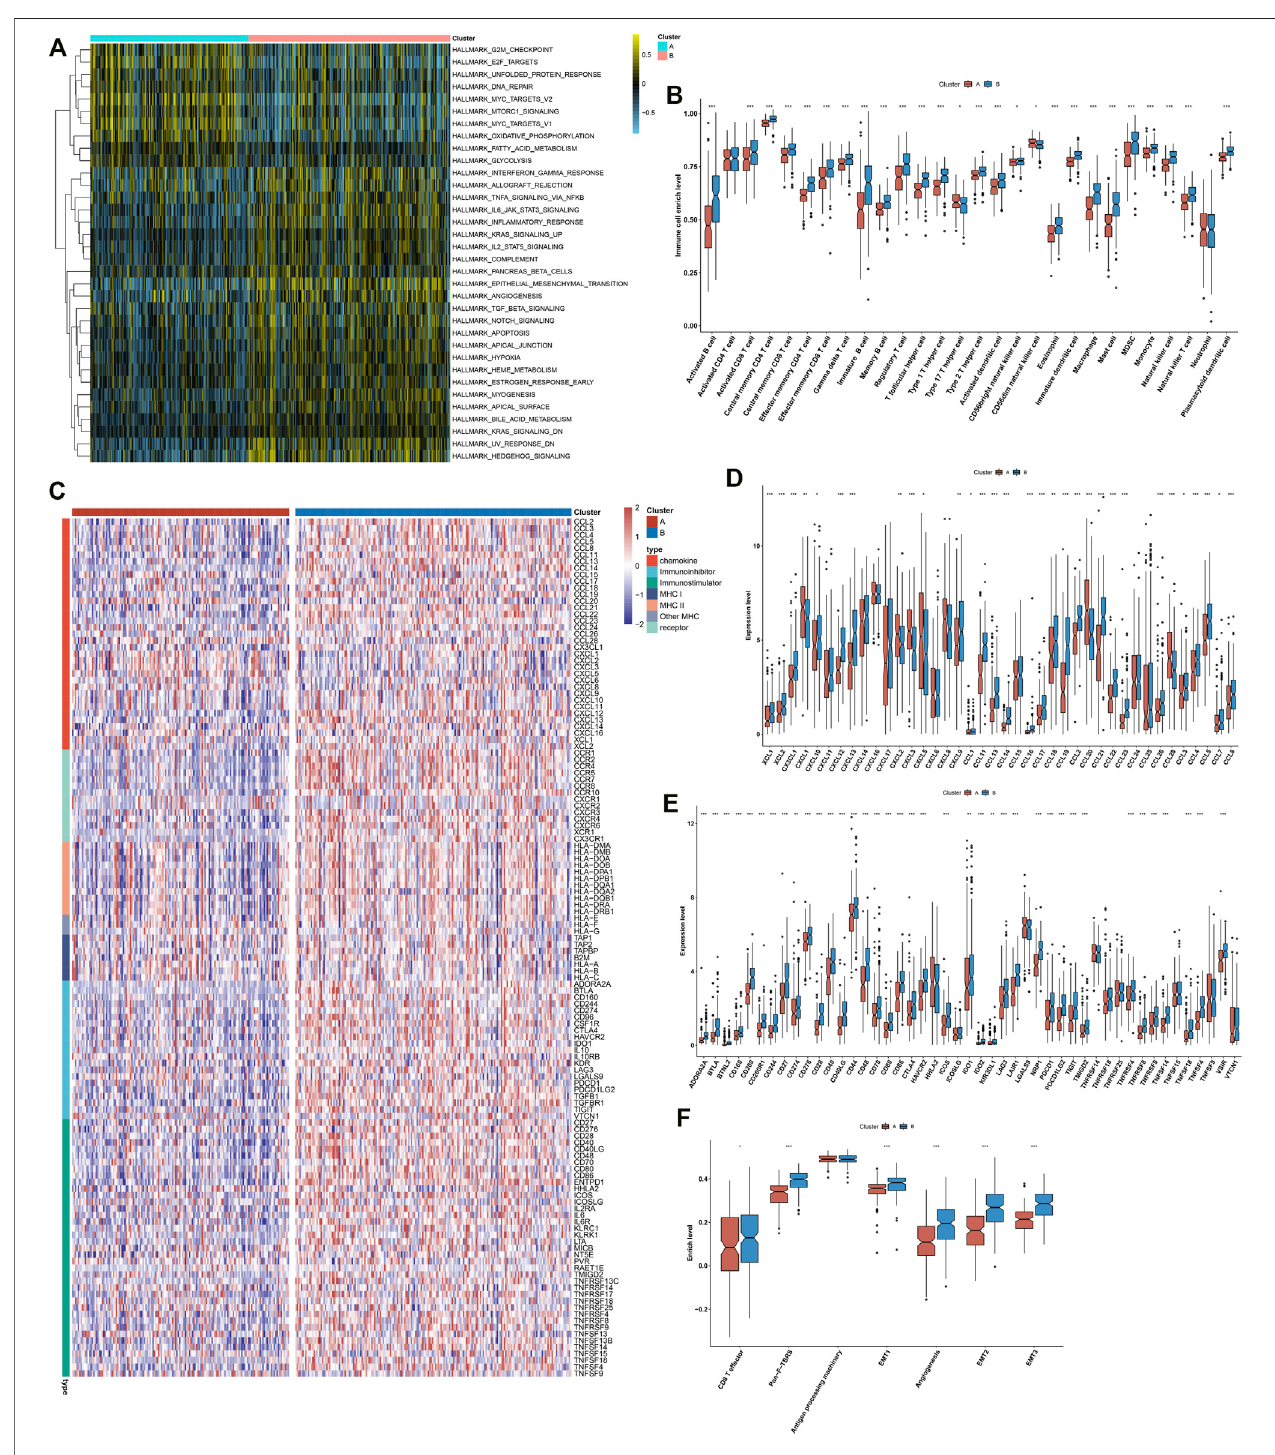
FIGURE 2 | Distinct immunological status in exosome-related phenotypes. (A) Visualization of the levels of hallmark pathways in exosome-related phenotypes A and B. (B) Differences in the in fi ltration levels of 28 immune cell types between the phenotypes. (C) Visualization of the expression of immunomodulatory molecules (chemokines, immuno-inhibitors, immuno-stimulators, MHC, and receptors) in the two phenotypes. (D , E) Differences in the expression of (D) chemokines and (E) immune checkpoints between phenotypes. (F) Comparisons of the levels of immune and stromal pathways between phenotypes. p p -value < 0.05; pp p -value < 0.01; and ppp p -value < 0.001.